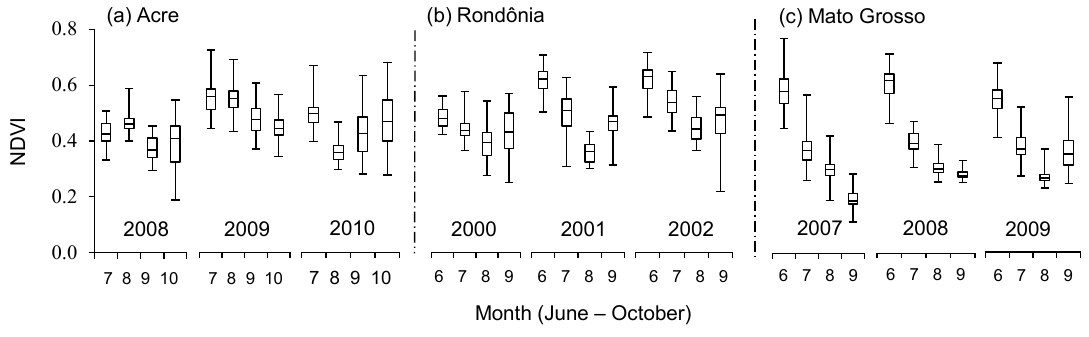
Figure 3. Variation in NDVI during the dry season among selected 50 samples at each site.